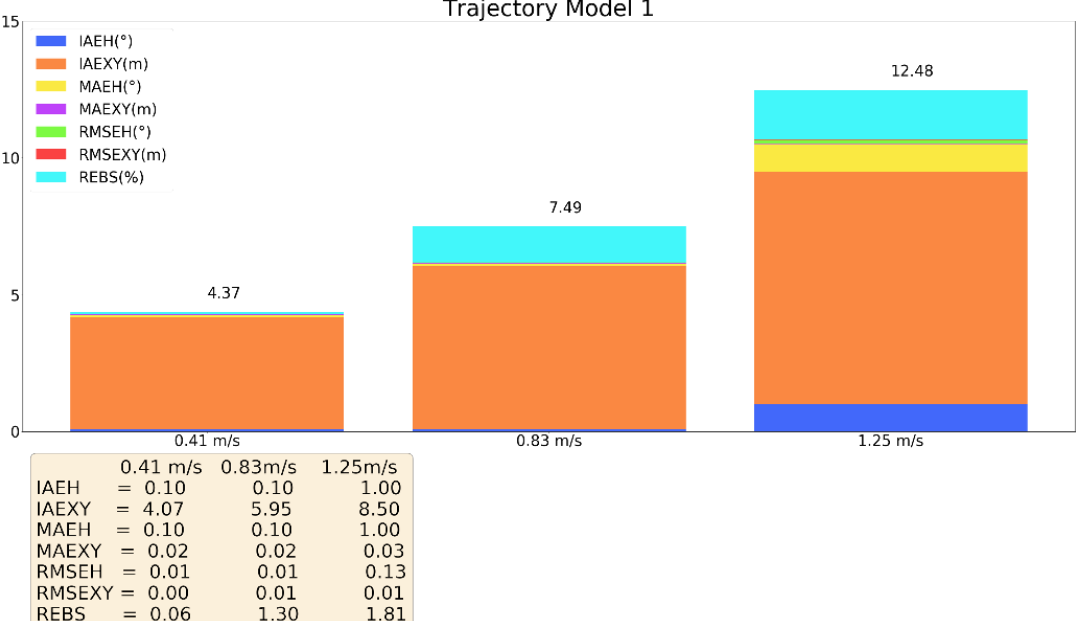
Figure 28. Seven parameters performance